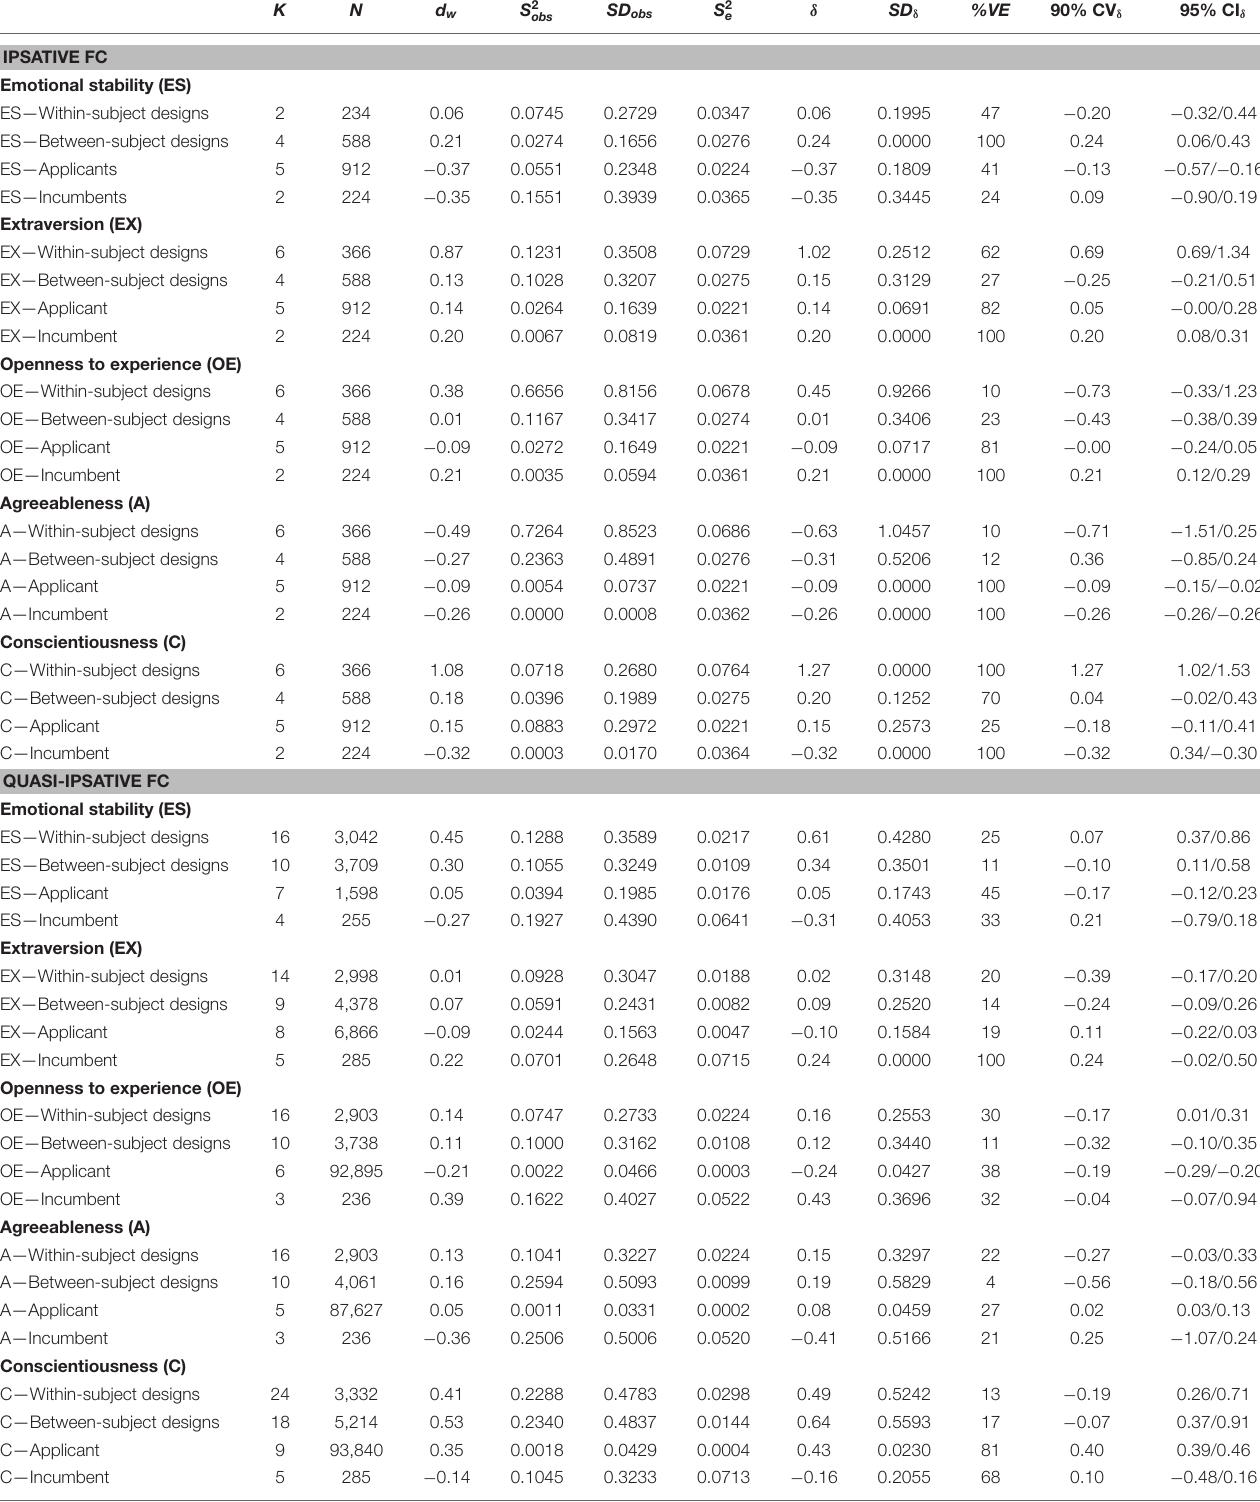
TABLE 5 | Hierarchical meta-analysis of the faking resistance of ipsative forced-choice inventories.